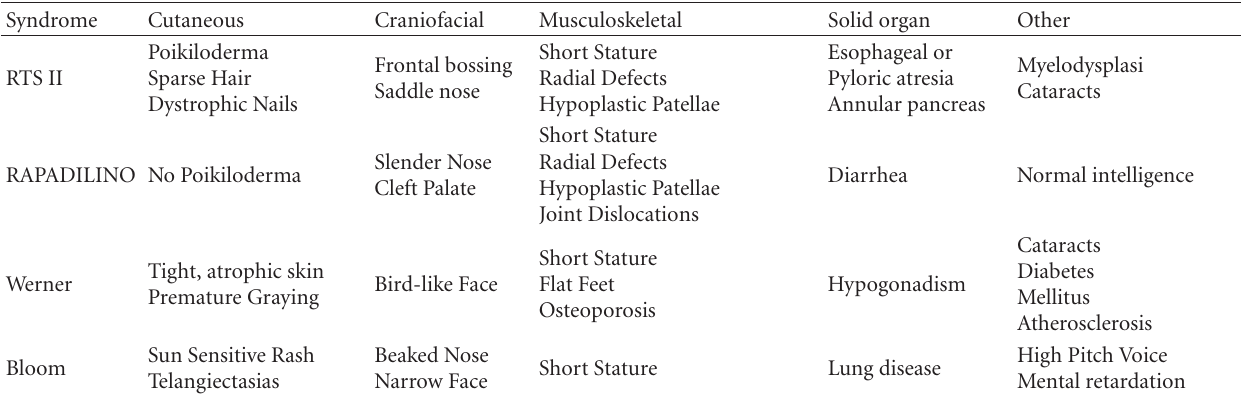
Table 4: Physical findings of RecQ